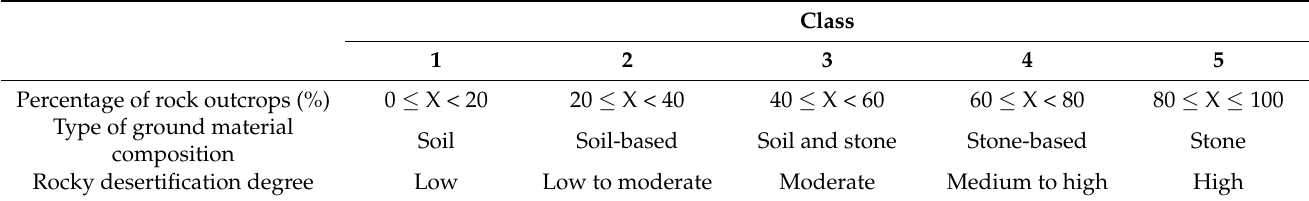
Table 1. Rocky desertification classes in karst